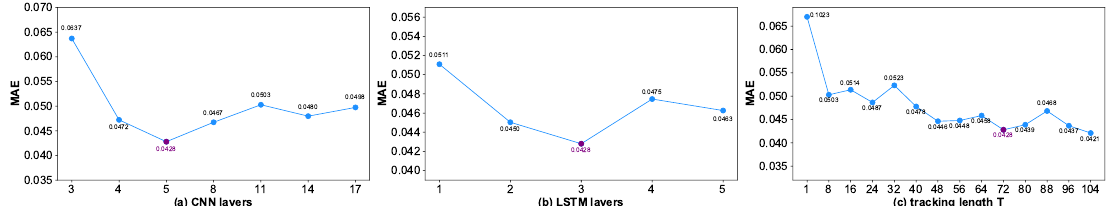
Figure 8. Performance on the validation set. ( a ) Performance of selecting different encoder layers. ( b ) Performance of selecting different decoder layers. ( c ) Performance of selecting different tracking lengths T .